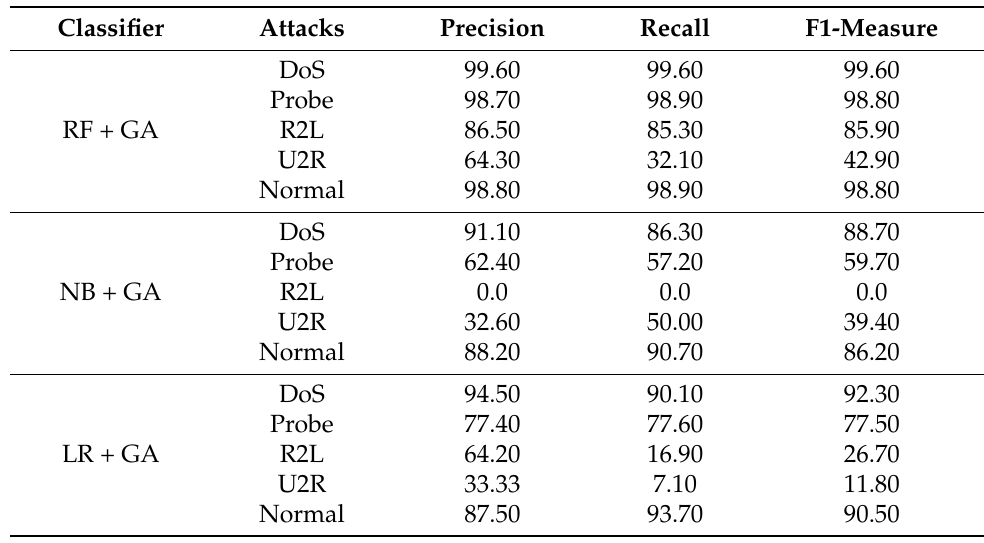
Table 4. Average classification report comparison of the proposed